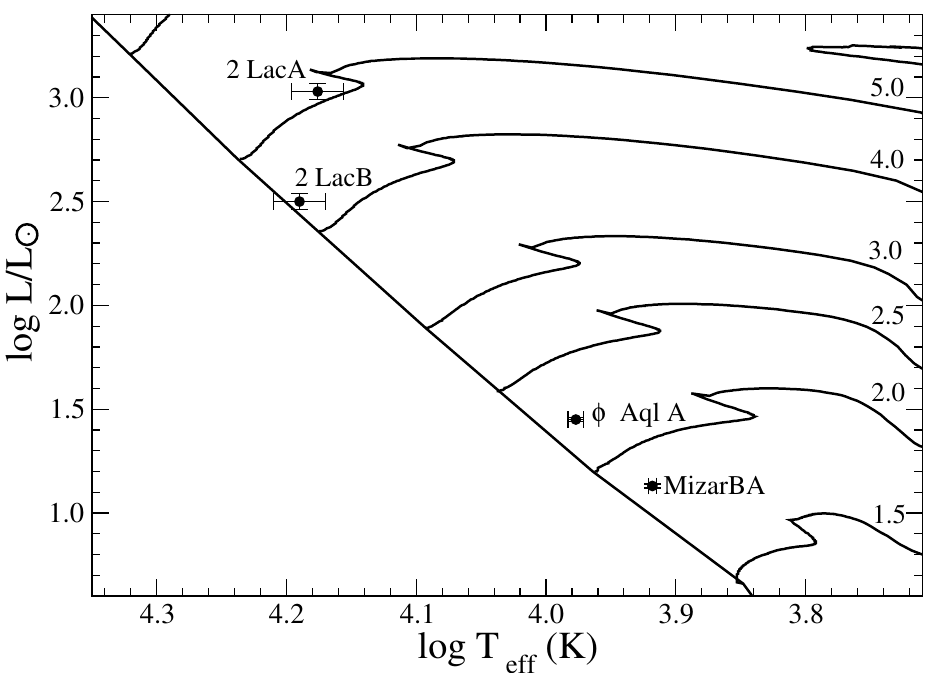
Figure 5. HR diagram with the positions of the studied systems. The parameters of the components of the 2Lac system were calculated using the mass ratio derived from the TCO orbital solution. Evolutionary tracks for single rotating stars are taken from [28] and shown by solid lines along with the location of the zero-age main-sequence. Numbers by the tracks indicate initial masses in solar